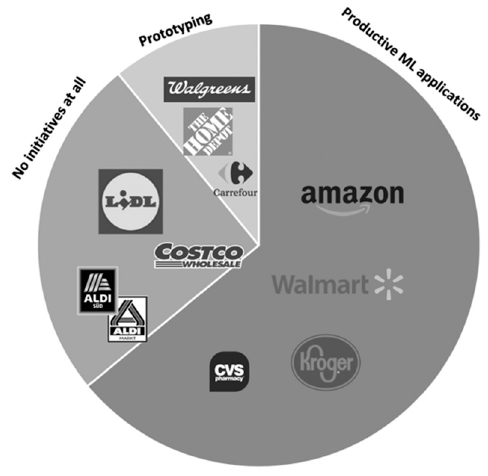
Figure 3. Diffusion of machine learning (ML) within the largest retail companies.